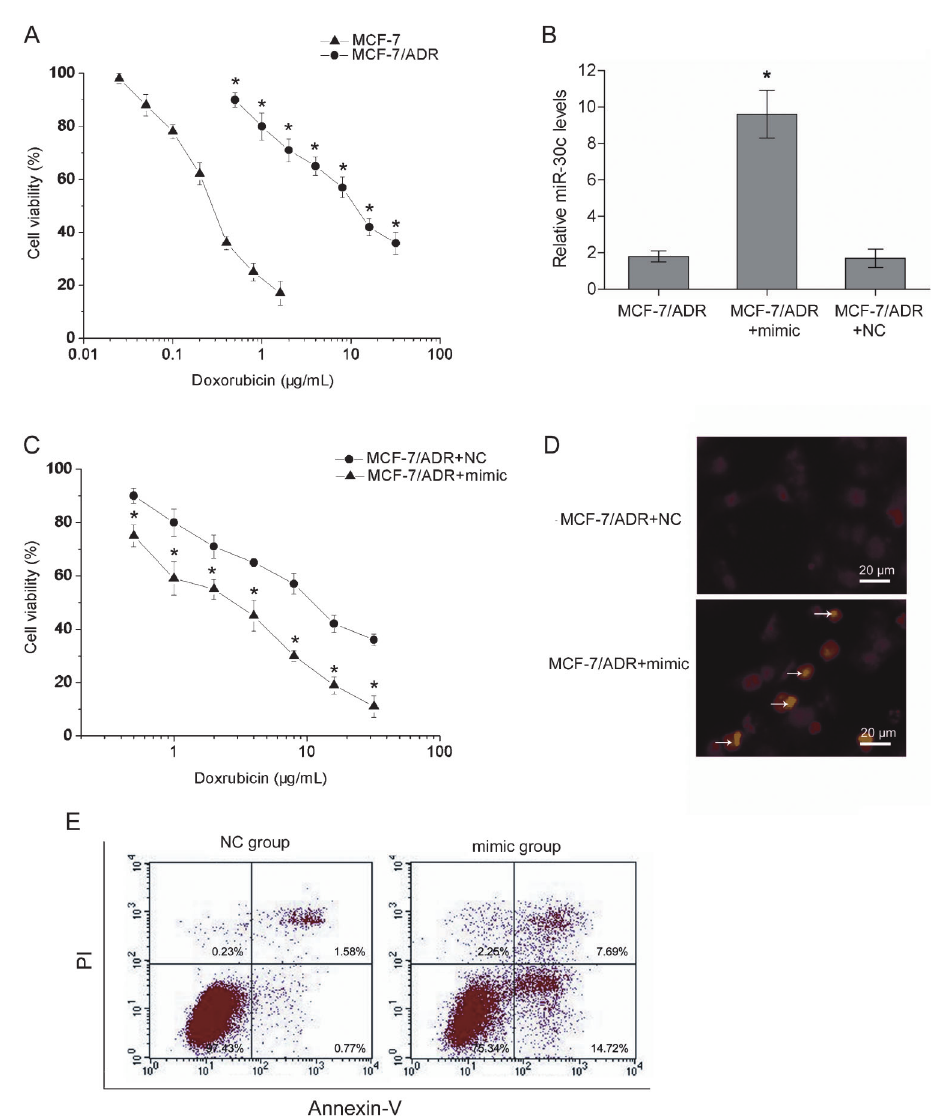
Figure 2. Overexpression of miR-30c sensitized the MCF-7/ADR cells to doxorubicin (ADR). A , Survival curves of MCF-7/ADR and MCF-7 cells. The cells were treated with various doses of doxorubicin. After 48-h incubation, the viability of cells was measured with the CCK-8 assay. The MCF-7/ADR cell line showed a 36.5-fold acquired resistance to doxorubicin based on IC 50 (12.078±0.368 vs 0.331±0.121 m g/ mL; *P , 0.05, Student t -test). B , qRT-PCR showed that the expression of miR-30c significantly increased in the cells transfected with miR- 30c mimic (*P , 0.05, Student t -test). C , After transfection with miR-30c mimic or negative control (NC) for 48 h, MCF-7/ADR cells were subsequently treated with various doses of doxorubicin for 48 h. Cell viability was determined using the CCK-8 assay. The IC 50 of miR-30c mimic and NC groupswas 4.008±0.342 and 10.977±0.275 m g/mL (*P , 0.05, Student t -test). D , After incubation with 5 m M doxorubicin for 2 h, the cells were washed three times with PBS, and then observed under a fluorescence microscope with a 400 6 lens. The intracellular accumulation of doxorubicin was more significant in the mimic group as indicated by arrows. E , Overexpression of miR-30c in MCF-7/ADR cells rescued doxorubicin-induced apoptosis after 48 h of 1 m M doxorubicin